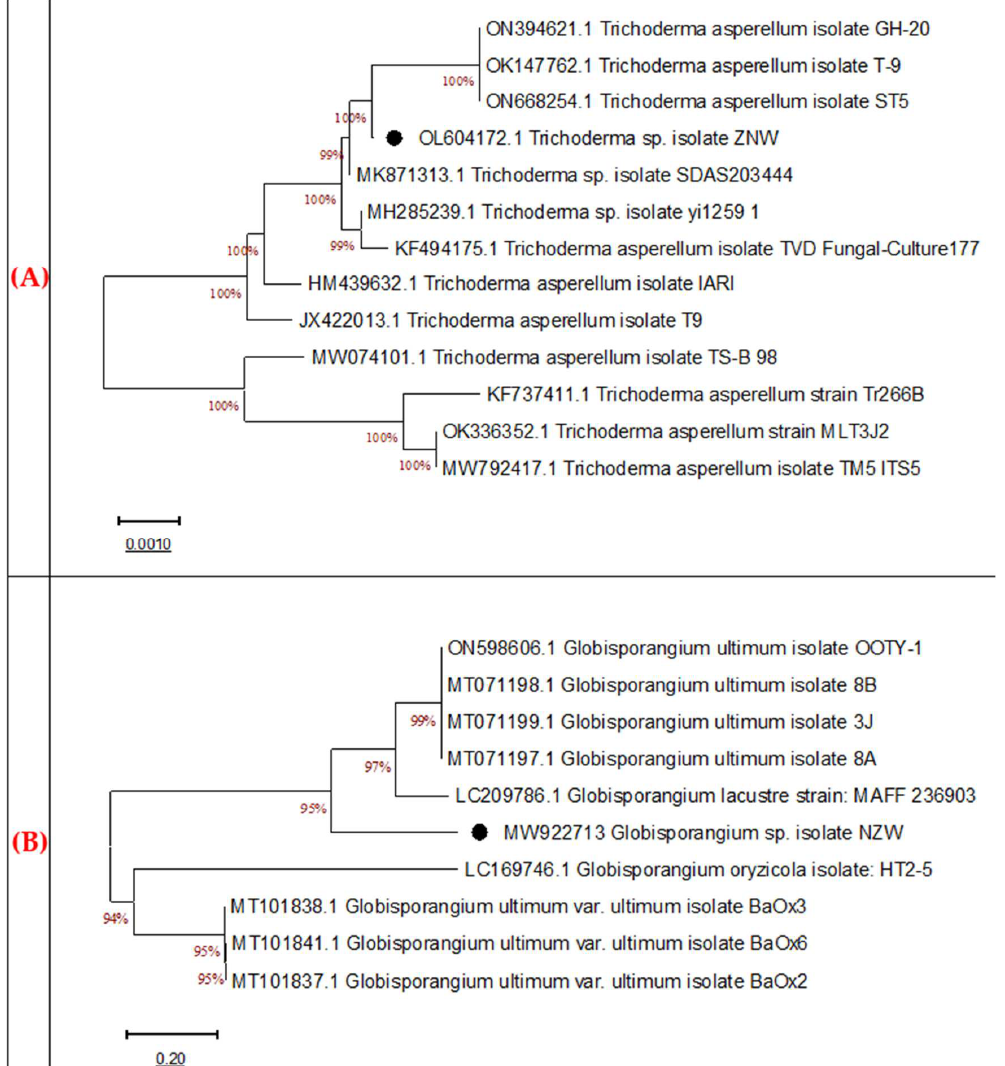
Figure 4. Molecular phylogenetic tree of the ITS for Trichoderma asperellum ZNW ( A ) and Globispo- rangium ultimum NZW ( B ) relation to the sequences obtained from GenBank.